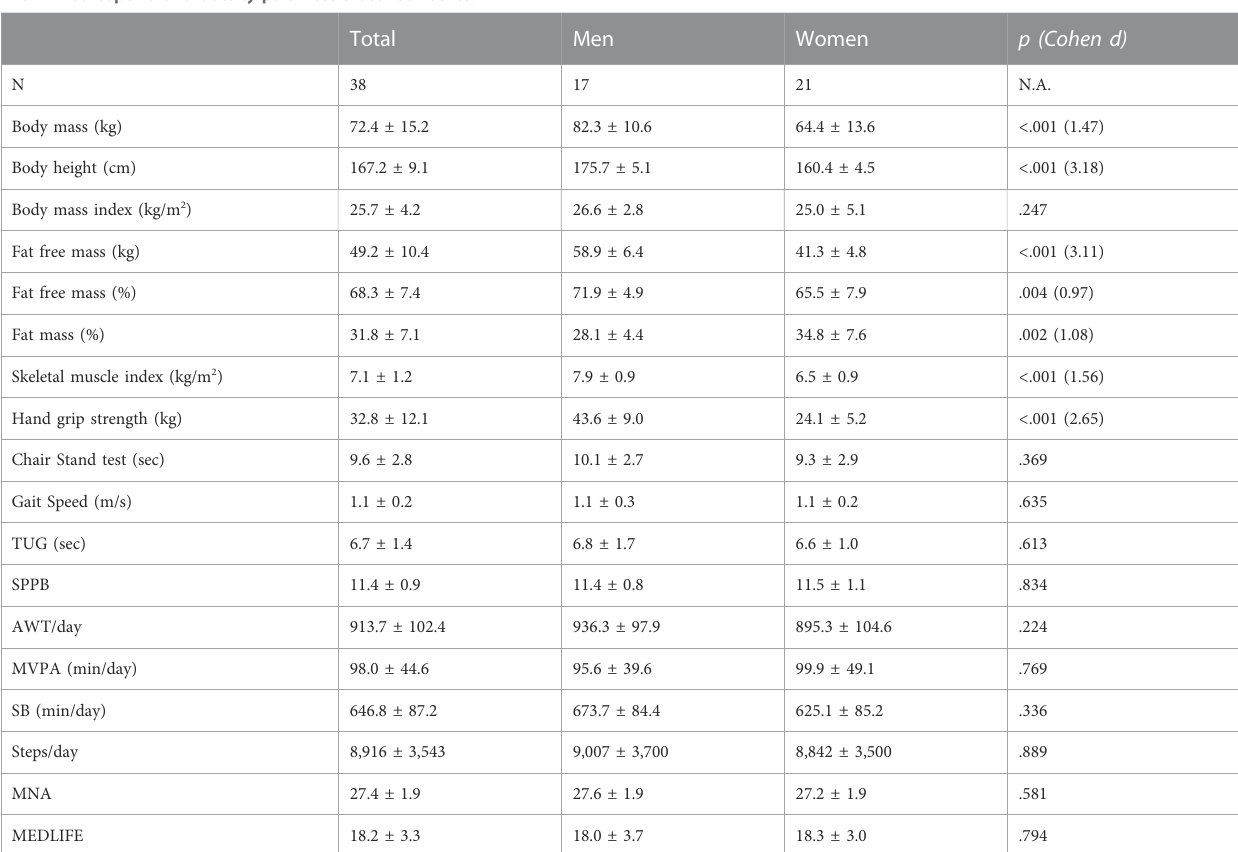
TABLE 2 Sarcopenia and obesity parameters between